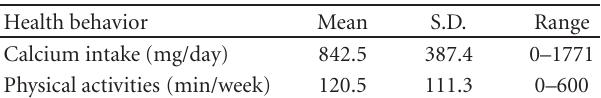
Table 3: Mean and standard deviations of calcium intake and participation in physical activities ( n =